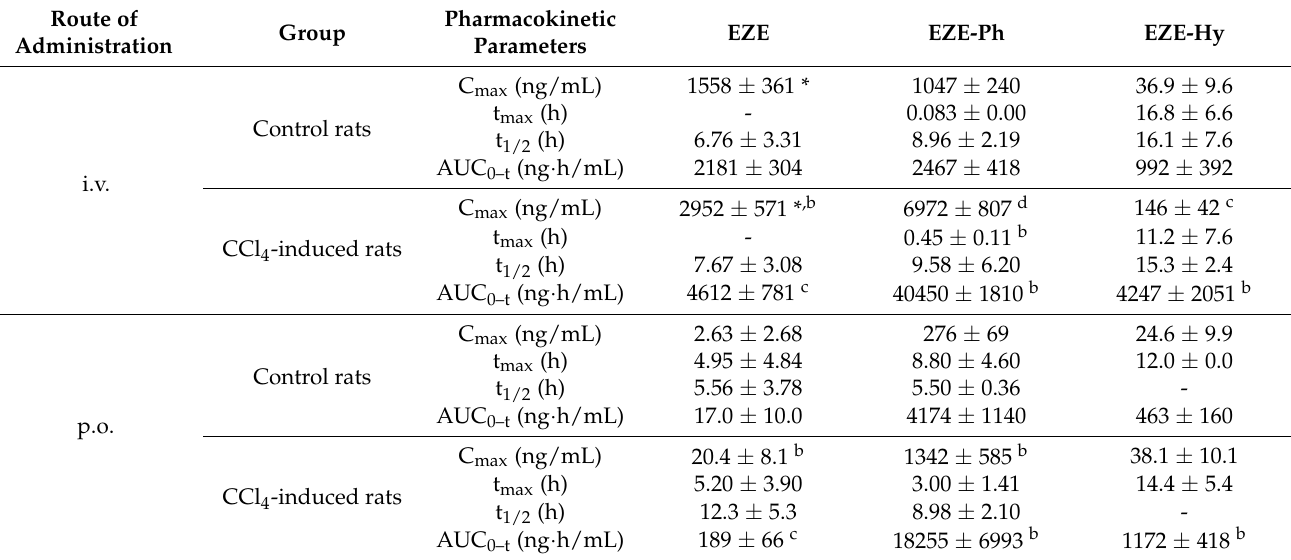
Table 2. Pharmacokinetic parameters of EZE and its major metabolites after intravenous and oral administration of 10 mg/kg of EZE to control ( n = 5) and CCl 4 -induced rats ( n = 5). Data are expressed as mean ±